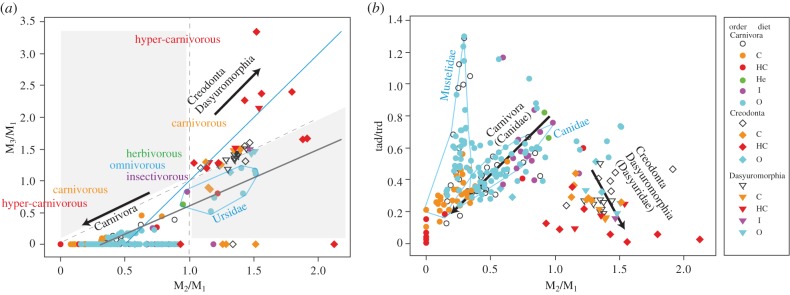
Variation and dietary adaptation pattern of lower molars in three mammalian orders. (a) Plots of M2/M1 versus M3/M1. Each data point indicates one species (electronic supplementary material, table S1); the shape indicates the taxon (circle, Carnivora; diamond, Creodonta; triangle, Dasyuromorphia) and the colour indicates the diet (orange, carnivorous; red, hyper-carnivorous; green, herbivorous; purple, insectivorous; blue, omnivorous). The blue line indicates the original regression line in the IC model [13]. The black line indicates the regression of the species in Carnivora that have three lower molars. The grey areas indicate patterns that cannot be explained by the IC model (M1 < M2 > M3 or M1 > M2 < M3) [14]. Omnivorous and insectivorous species tend to have equal-sized molars. Carnivorous carnivorans tend to have larger M1, but carnivorous creodonts and dasyuromorphians tend to have larger mesial molars (smaller M1). Arrowed lines indicate two types of carnivorous adaptations among three orders. (b) Plots of M2/M1 versus tad/trd. Carnivorous species tend to have relatively larger trigonids relative to omnivorous and insectivorous species in all three orders.